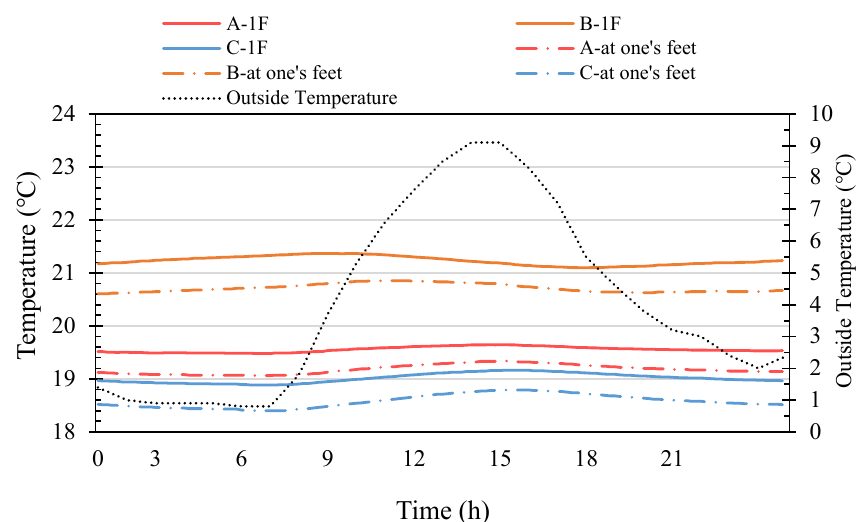
Figure 10. Room temperature change over time in the first-floor living area (Zone 4) and near the floor (Zone 2).